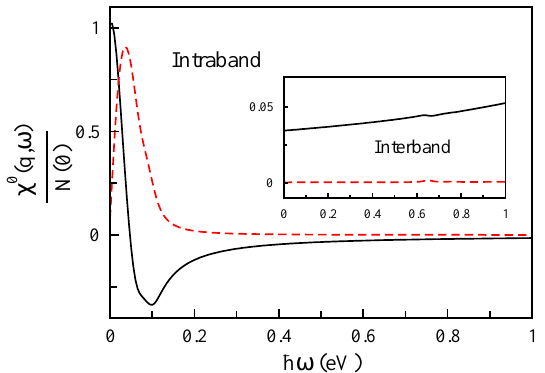
Figure 9. The interband and intraband of non-interacting response function ( χ 0 ( q , ω ) ) of doped MoS 2 in units of the Fermi-level density of states as a function of ¯ h ω for q = 0.069 Å − 1